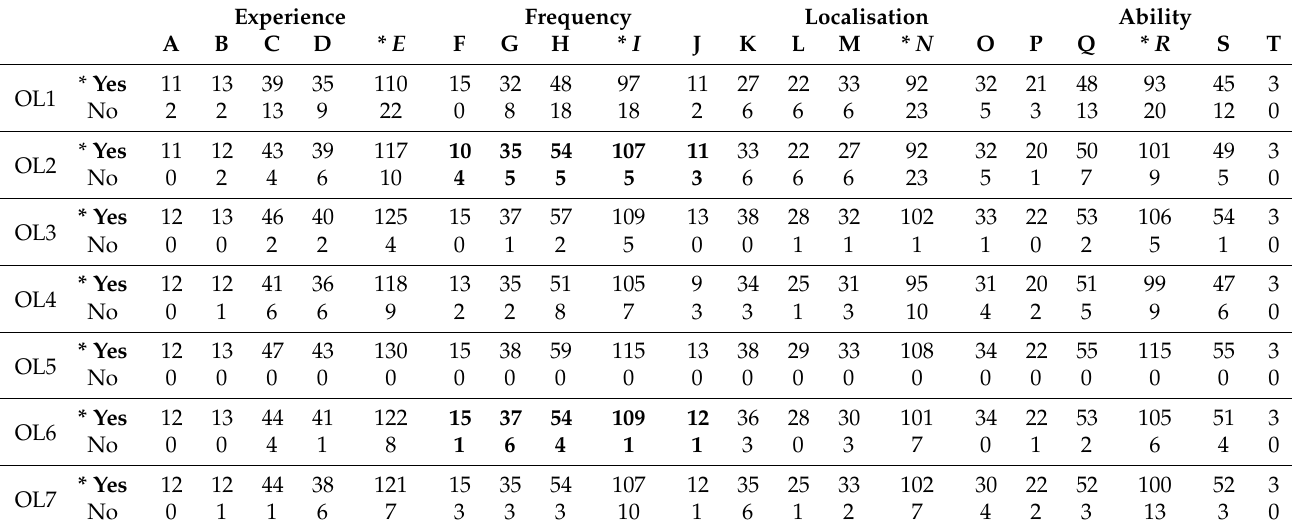
Table A3. This is a contingency table displaying data from surfer variables (questions 1–4) and Ocean Literacy Principles (question